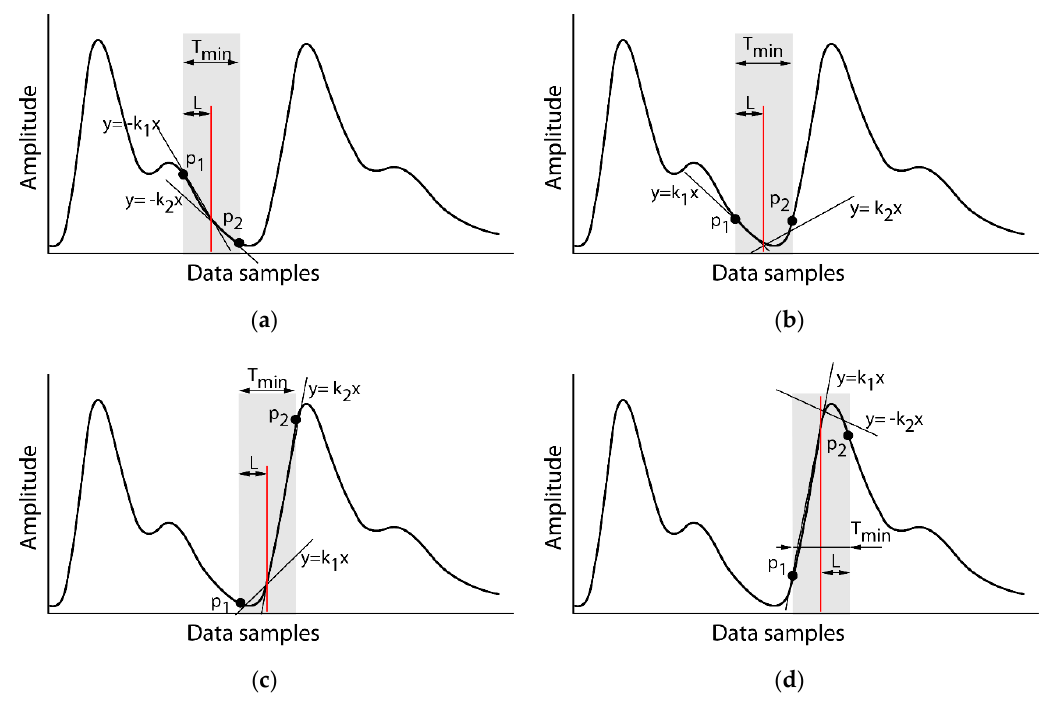
Figure 9. ( a ) PPG signal’s falling edge in PDW; ( b , c ) PPG signal’s falling and rising edge without a peak point in PDW; ( d ) PPG signal with a peak point in PDW. PDW: Peak detection window.